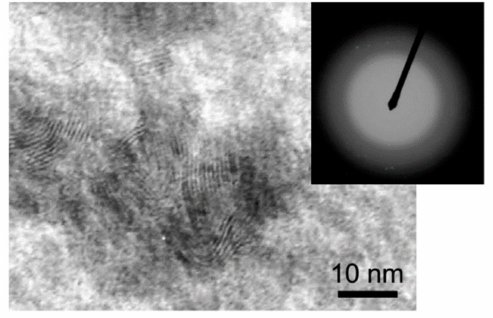
Figure 5. High-resolution TEM image of the Mo-S-C-H thin film obtained by reactive PLD at an H 2 S pressure of 5.5